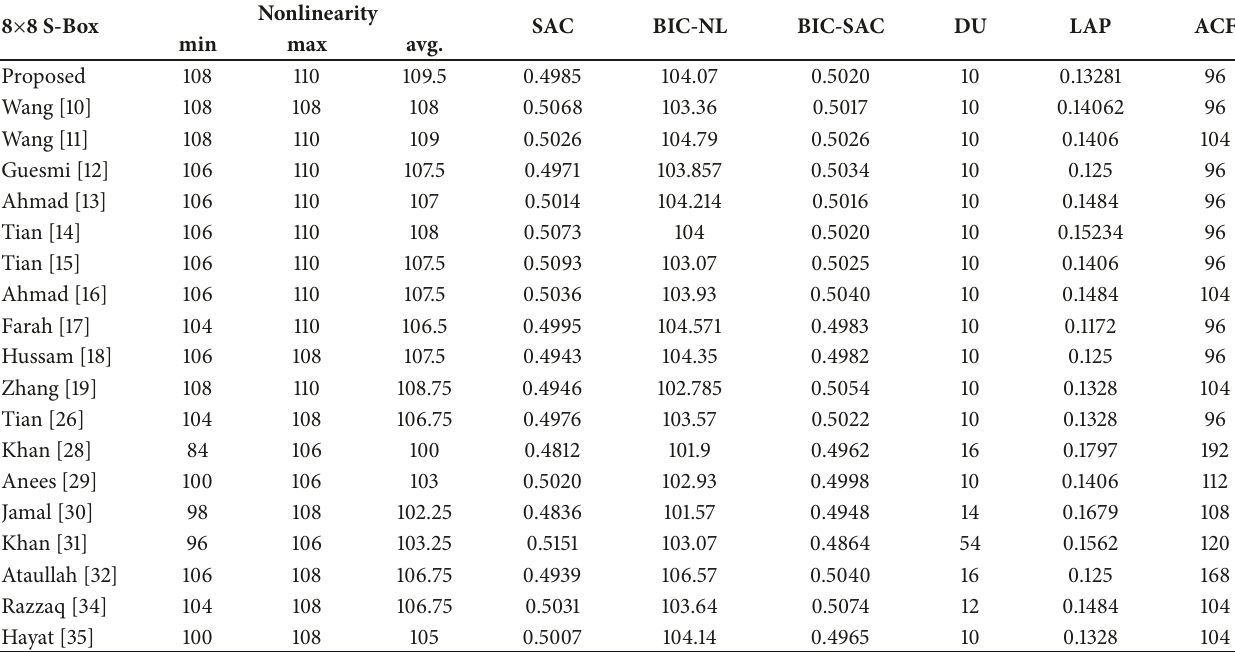
Table 17: Comparison of some recent optimization techniques based 8 × 8